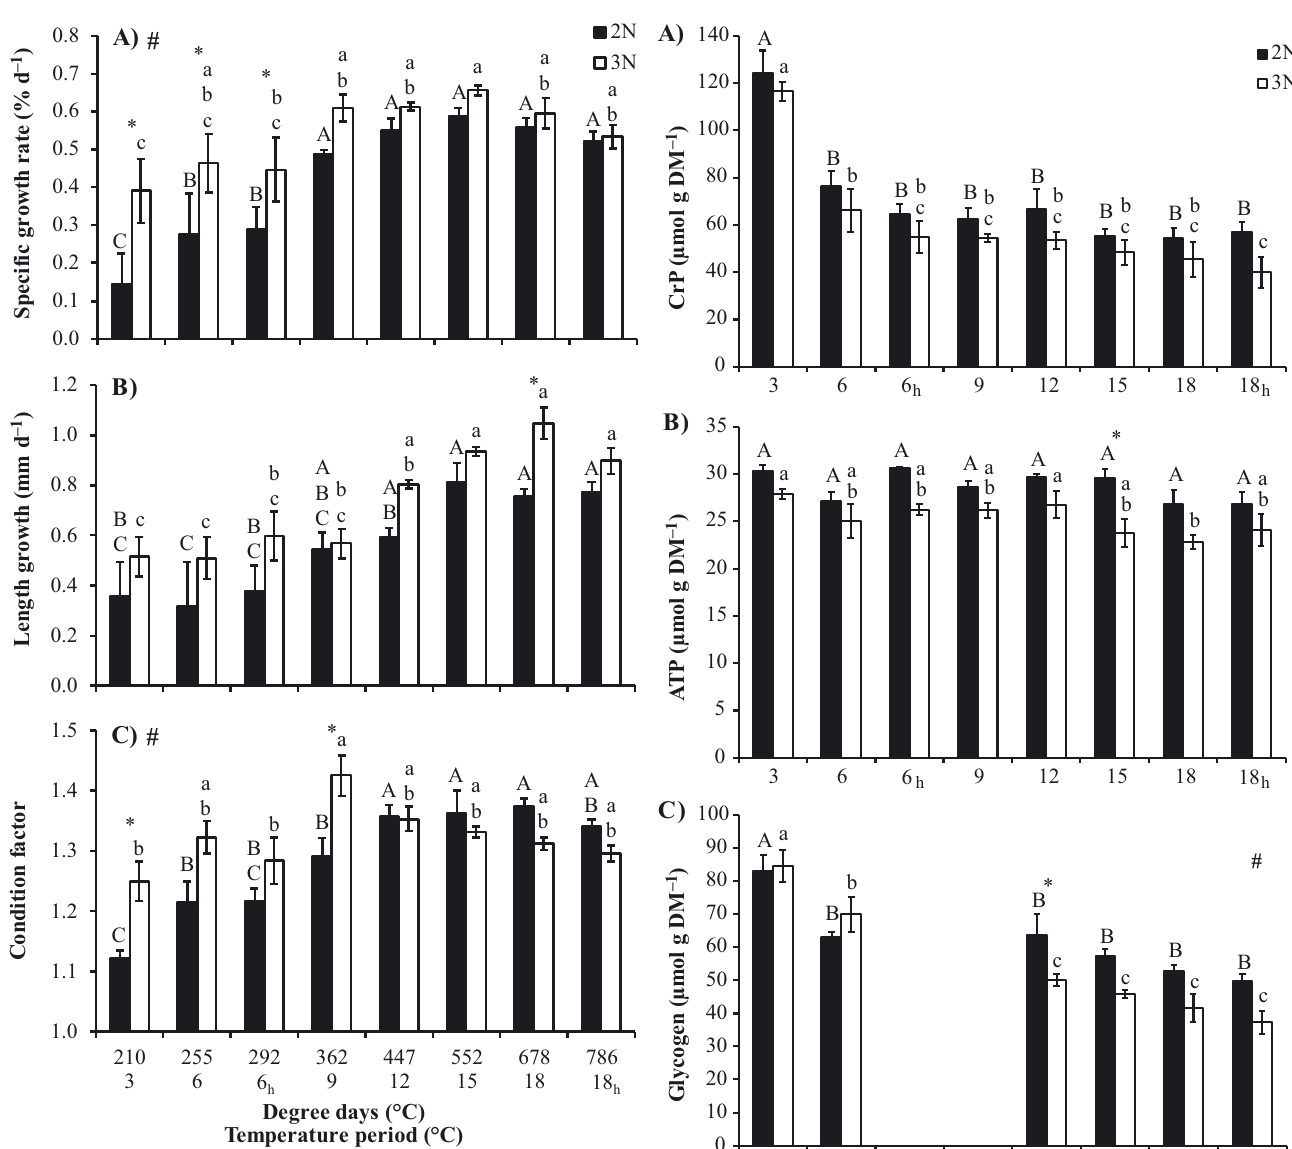
Fig. 3. Mean ± SE (A) specific growth rate, (B) length growth and (C) condition factor of large diploid and triploid Atlantic Fig. 4. Mean ± SE white muscle (A) creatine phosphate salmon Salmo salar in seawater. See Fig. 2 for explanation of (CrP), (B) adenosine triphosphate (ATP) and (C) glycogen symbols levels in large diploid and triploid Atlantic salmon Salmo salar in seawater. n.d.: no data due to technical failure. DM: dry mass. See Fig. 2 for explanation of